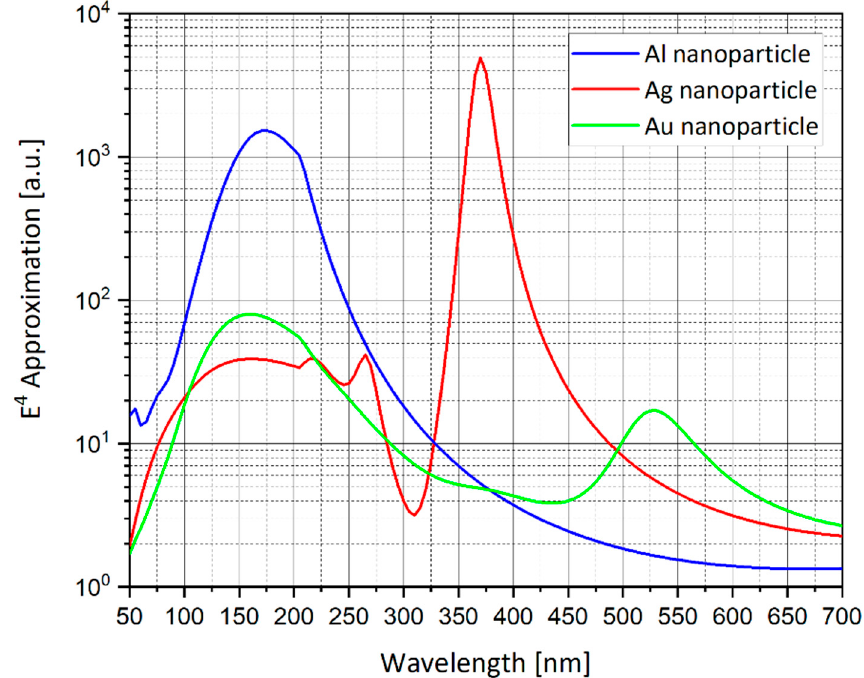
Figure 14. Field Enhancement vs. wavelength for an incident plane wave on a silver (Ag), gold (Au) and aluminum (Al) 20 nm-radius sphere. The E 4 approximation for the electric field enhancement is displayed. Relevant wavelength peaks: silver at λ = 370 nm, gold at λ = 530 nm, aluminum at λ = 175 nm.